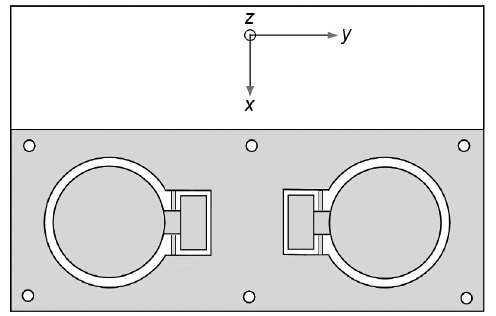
Fig. 3. Top view of the differential accelerometer mechanics. Two identical torsion pendula are carved out of a single-crystal sapphire plate by means of CNC ultrasonic impact grinding. The two disks are used as the tuning elements of two sapphire-loaded mi- crowave resonators. Two flaps with evaporated gold electrodes are used for electrostatic stiffness fine bal- ancing and cold damping of the